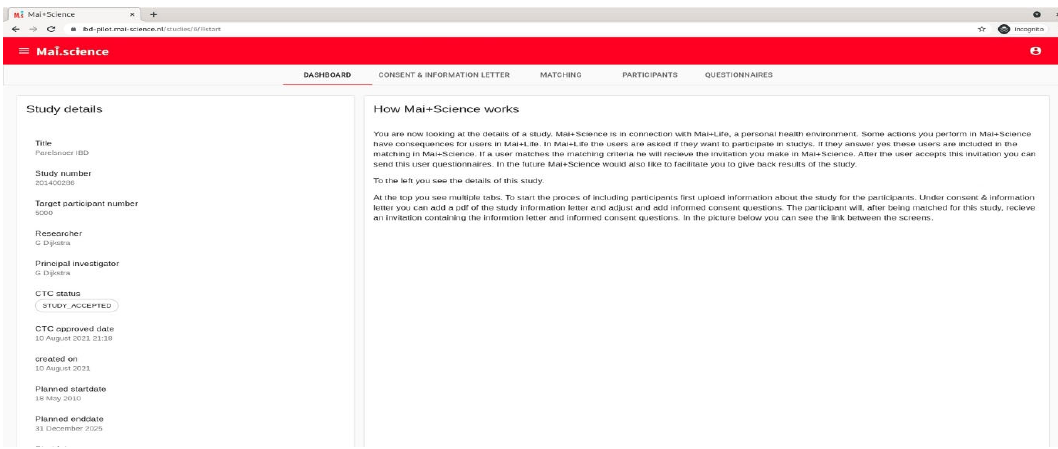
Figure 2. Pilot study design with Research Connection.